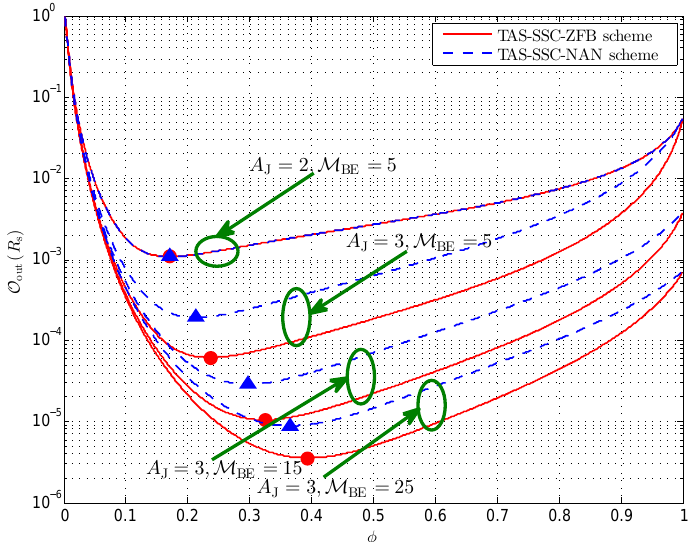
Figure 5. Secrecy outage probability versus different φ for γ T = 10 dB, A A = 3, N B = 2, R s = 1, and γ S = 20